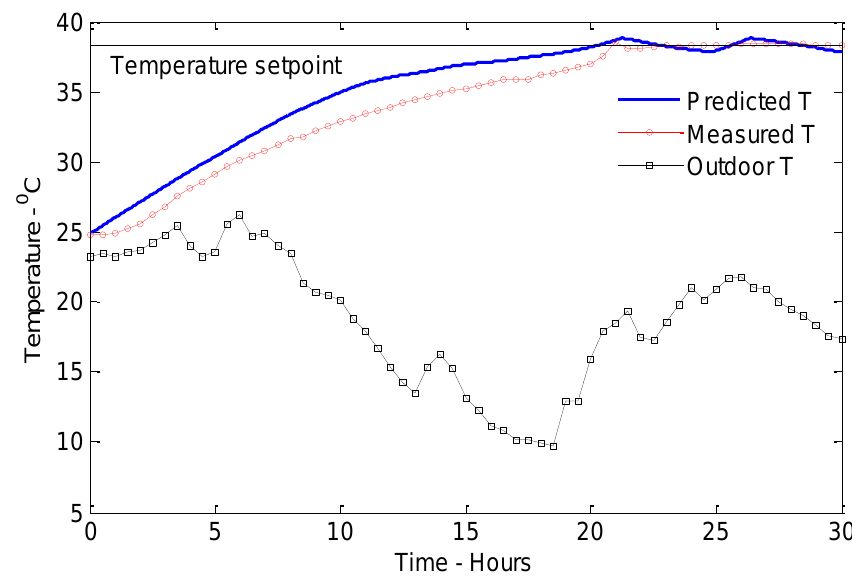
Figure 6. Variation of the internal and external air temperatures for Case 1.